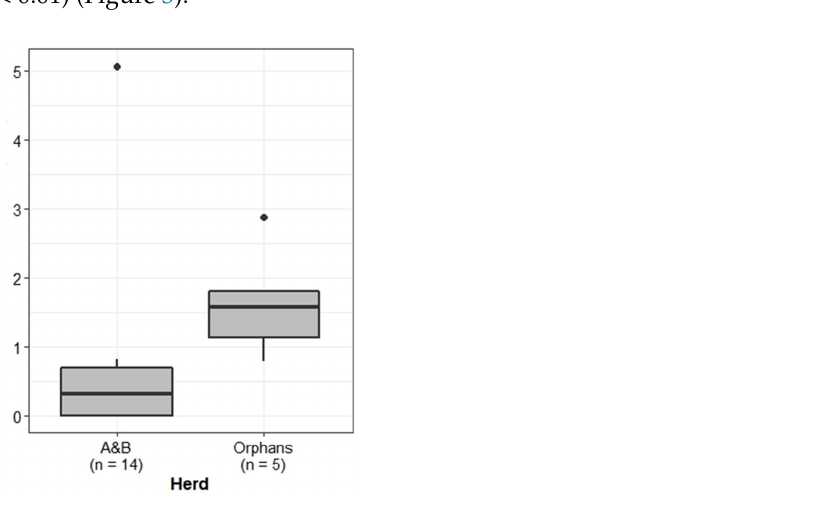
Figure 3. Proportion of time the A&B herd and Orphans spent exhibiting vigilance behaviour. Box- plots show median, IQR, and outliers. Numbers on the x -axis indicate the number of individuals included in the analysis for each herd.